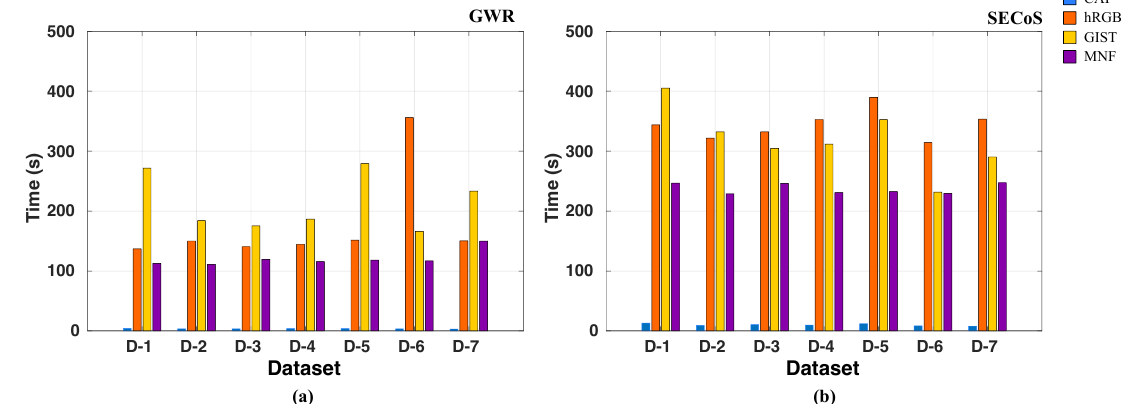
Figure 10. Average CPU time (seconds) to generate a specific novelty detector for each dataset by using different feature extraction techniques: ( a ) GWR detectors; ( b ) SECoS